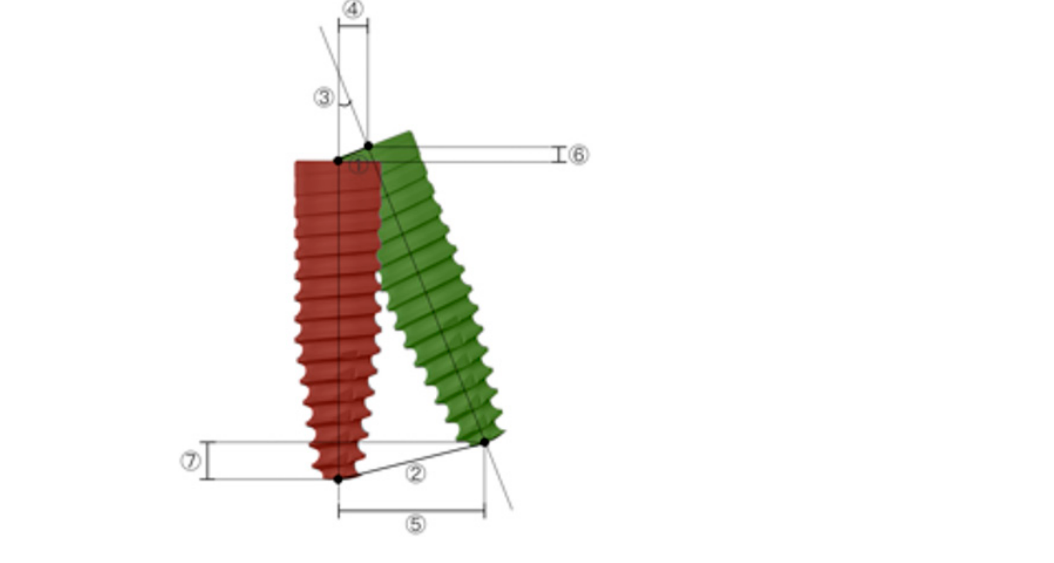
Figure 8. The target parameters measured in the deviations between the positions obtained by the DNS-based method (green color) and the postoperative CBCT (red color) results. ① Entry deviation (3D deviation at the implant shoulder); ② apex deviation (3D deviation at the implant apex); ③ angular deviation; ④ horizontal deviation at the entry point; ⑤ horizontal deviation at the apex point; ⑥ vertical deviation at the entry point; and ⑦ vertical deviation at the apex point.